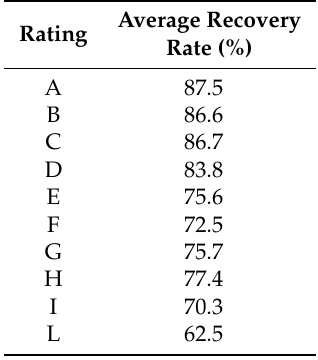
Figure 5. The Figure shows the box plot of the recovery rates computed by the banks divided into the rating classes. We note that the RR decreases from A to L, even though not monotonously. Table 9. The table shows the average recovery rate derived from the field AS37 of the ECB template. We can see that the RR are decreasing from A-rated to L-rated companies, even though not